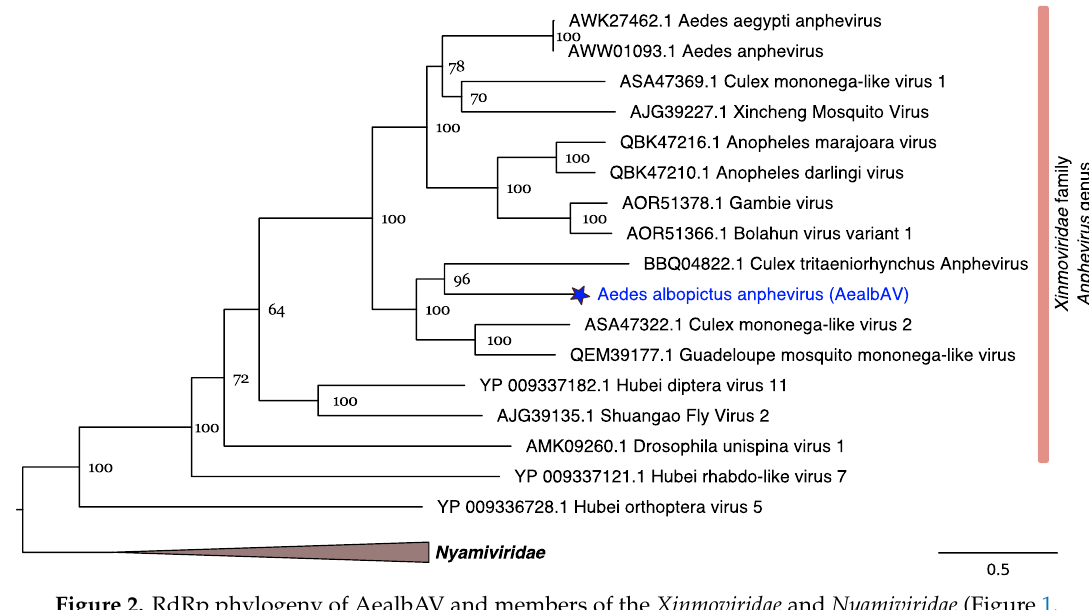
Figure 2. RdRp phylogeny of AealbAV and members of the Xinmoviridae and Nyamiviridae (Figure 1. bootstraps were performed). Branch lengths represent expected numbers of substitutions per amino acid